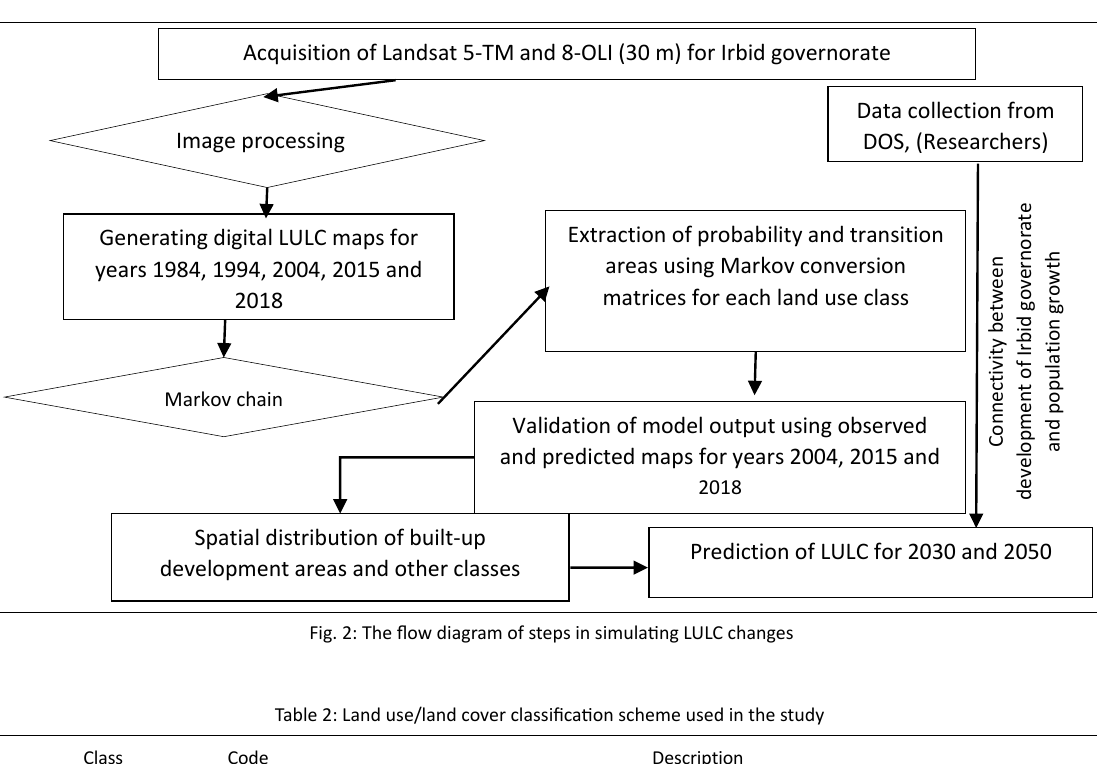
Extraction of probability and transition areas using Markov conversion